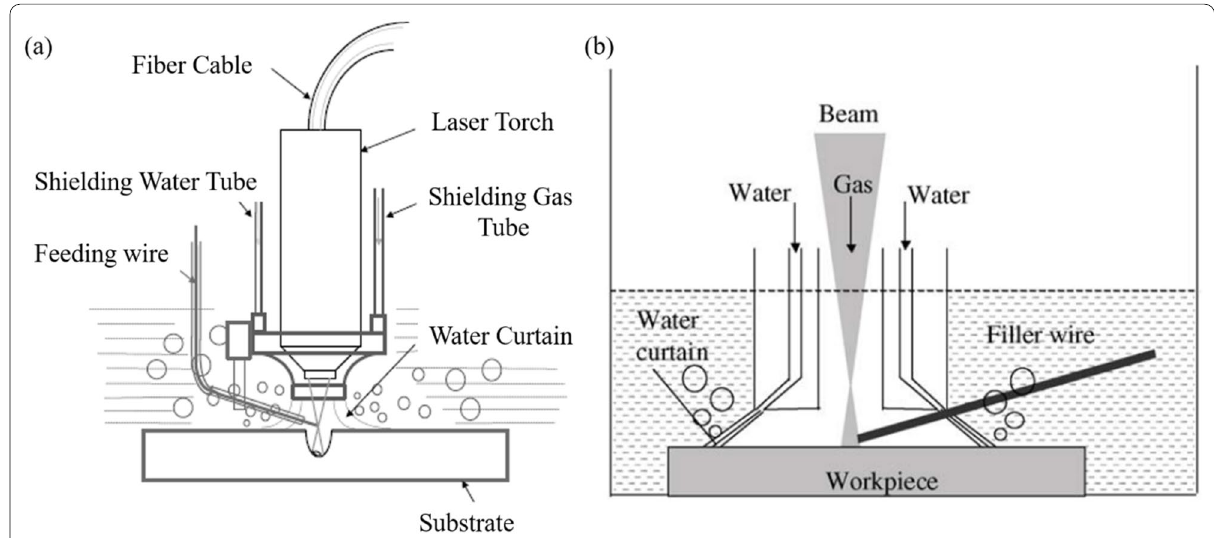
Figure 4 Schematic of the drainage devices with water curtain developed by ( a ) Hitachi in Japan [31] and ( b ) Tsinghua University in China